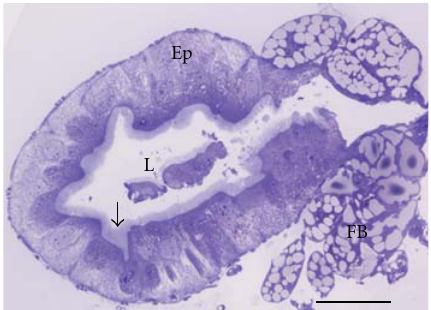
Figure 24: Anterior duct of a N. abietis larva salivary gland showing the single layer of epithelial cells (Ep) with a border of microvilli (arrow) lining the lumen (L) of the duct. Fat body (FB) cells are pressed against the duct. Scale bar = 0.1mm.